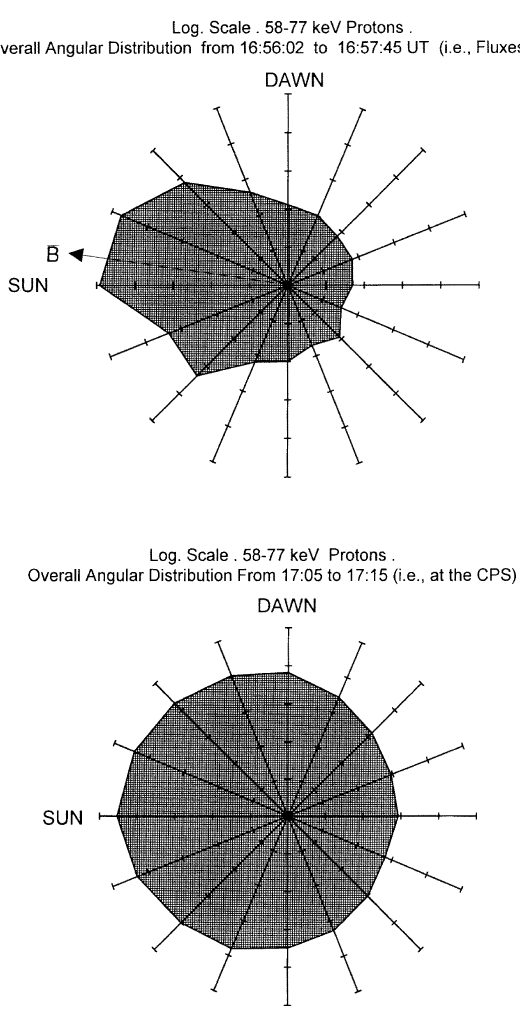
Fig. 13. Overall angular distributions at the PSBL and the CPS of the 58–77-keV protons in logarithmic scale. The particles stream along the magnetic field lines although at the CPS a less anisotropic character is apparent. The dominant direction of flux is tailward and the dawn points-upward